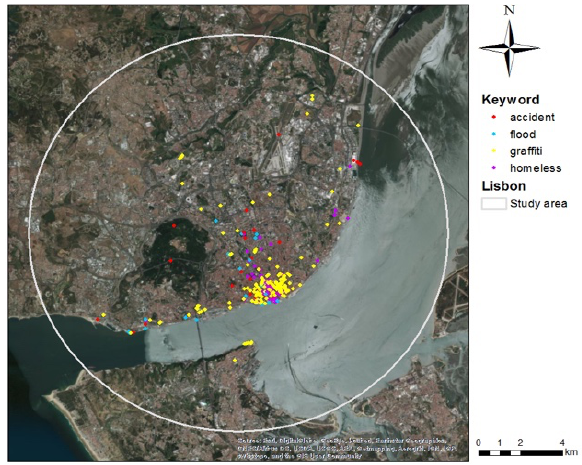
Figure 3. Position of the extracted posts for the Lisbon study area, coloured according to the keyword used in the search, and the major